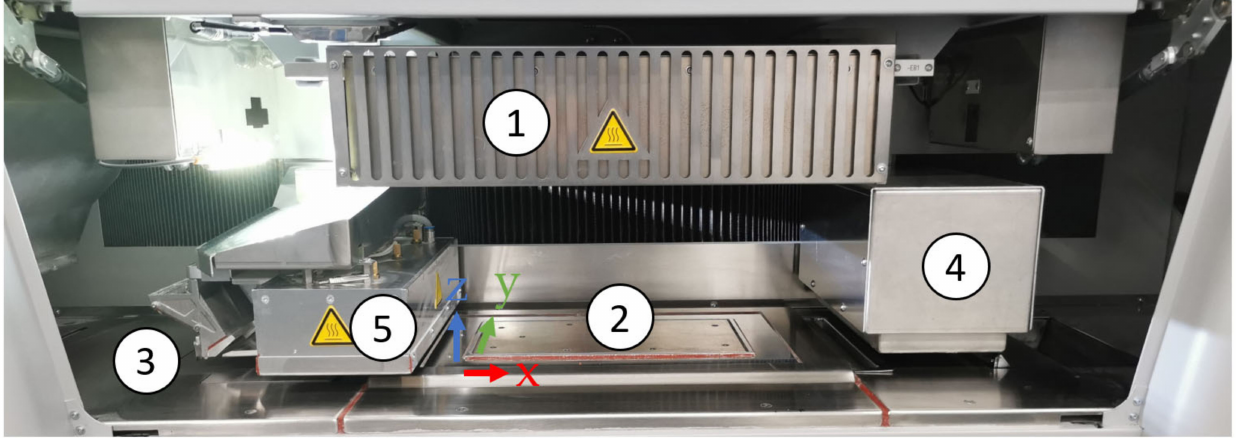
Figure 1. View of the voxeljet VX200 HSS machine: overhead lamp ( 1 ), built box ( 2 ), re-coater ( 3 ), printing module ( 4 ) and sintering lamp ( 5